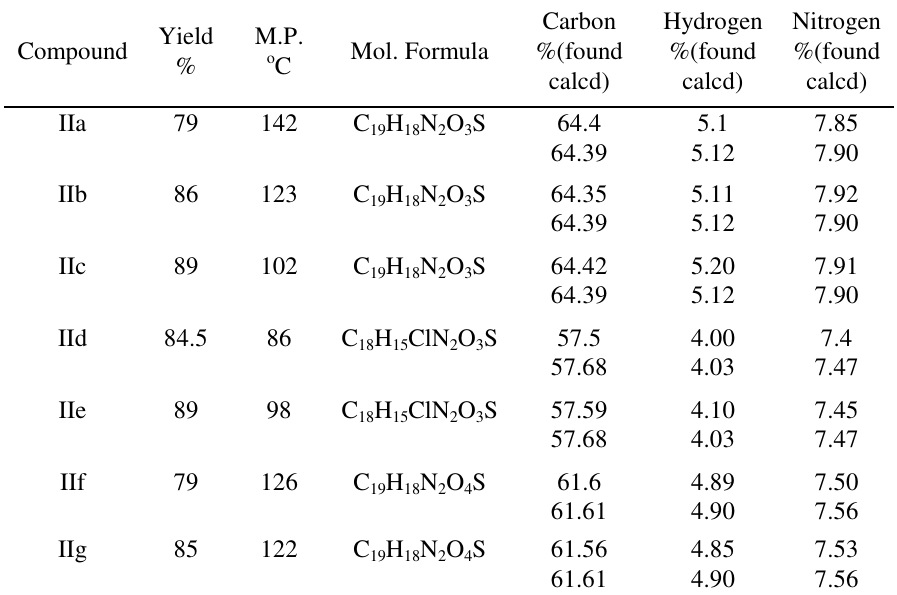
Table 3 . General characteristics and elemental analysis data of the compounds II